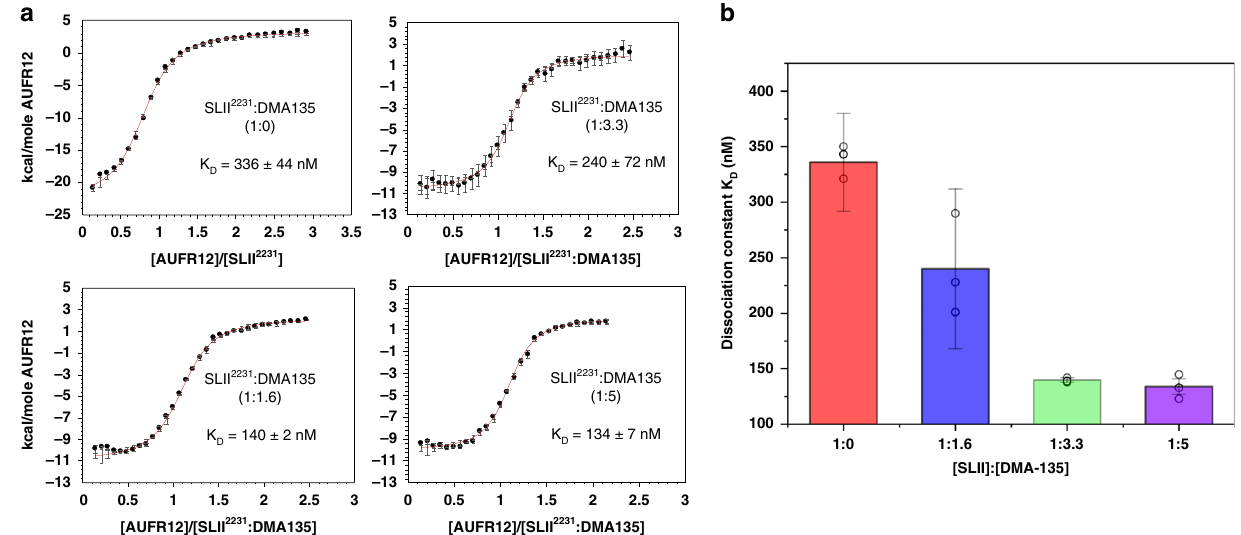
Fig. 6 DMA-135 allosterically stabilizes a AUF1-SLII-(DMA-135) ternary complex. a Calorimetric titrations of AUF1-RRM1,2 to SLII or to SLII:DMA-135 complex at different molar ratios reveal a single transition in the binding isotherm characterized by an enthalpically driven molecular recognition event. All data were processed and analyzed using Af fi nimeter 25 . The processed thermograms were fi tted to a 1:1 stoichiometric binding model, represented by the red lines. Values for dissociation constants ( K D ) and corresponding standard deviation are reported for each titration. The experiments were performed in 10 m M K 2 HPO 4 , 20 m M KCl, 0.5 m M EDTA, and 4 m M BME (pH 6.5) buffer at 298 K. b Graphical representation of the dissociation constants for the AUF1- RRM1,2-SLII complex as a function of DMA-135 concentration. Reported K D values and corresponding standard deviations are from n = 3